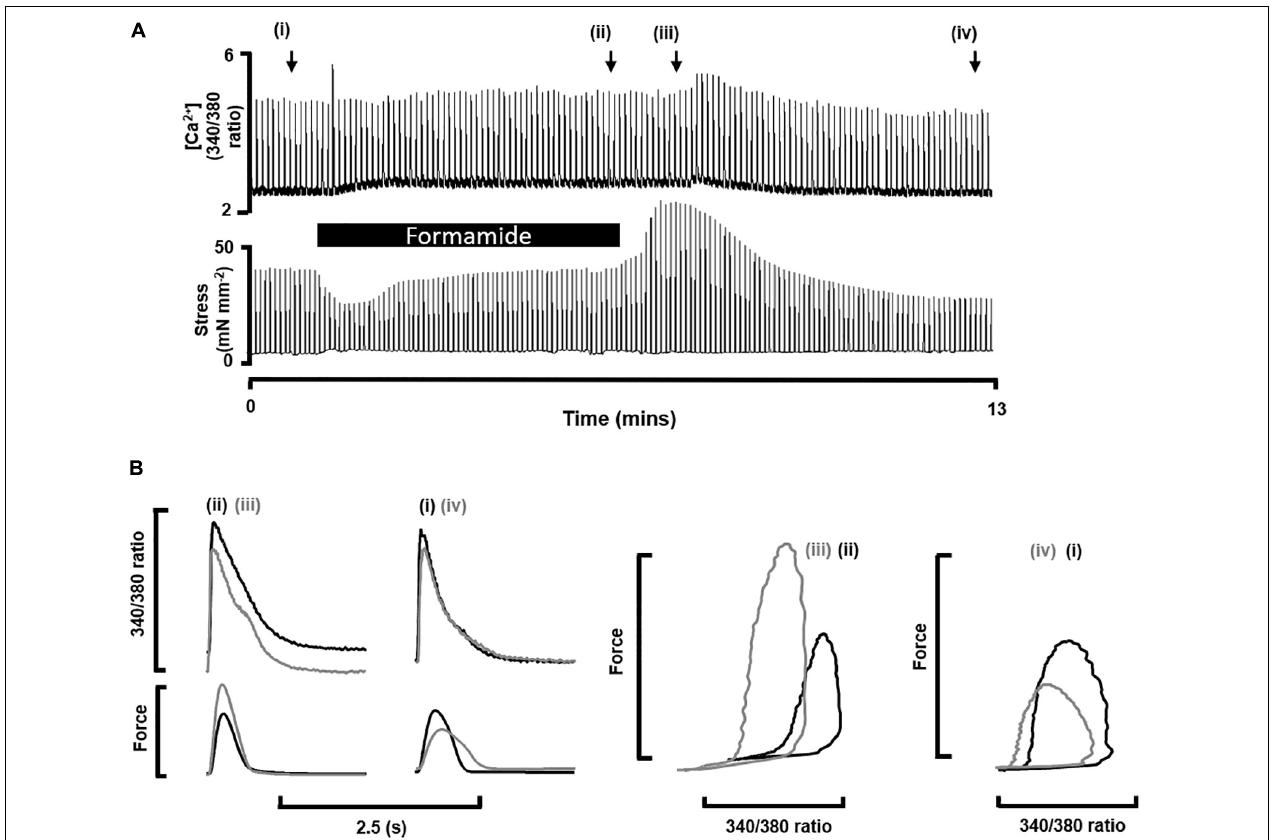
FIGURE 1 | Impact of formamide on multicellular trabeculae. (A) Shows continuous trace of [Ca 2 + ] i as fura-2 340/380 fluorescence (top) and isometric force (bottom) recorded from a representative trabecula stimulated at 0.2 Hz before (i), during (black bar, ii) and after (iii,iv) exposure to 1.5 M formamide. The x-axis shows time, and the black bar indicates 5 min of formamide exposure. (B) Shows examples of individual [Ca 2 + ] i and twitch force traces from the time points labeled in (A) .